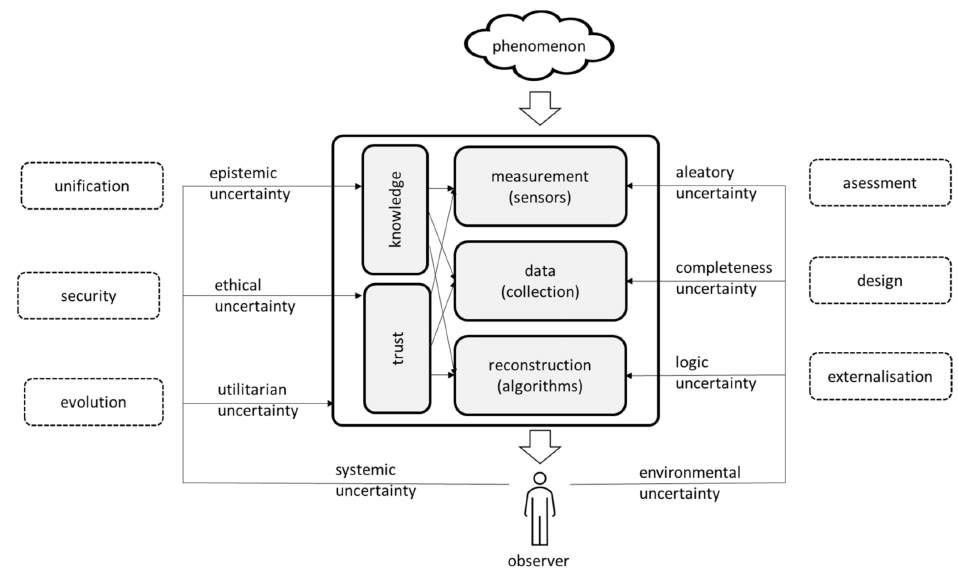
Figure 2. The sensor network as a measurement